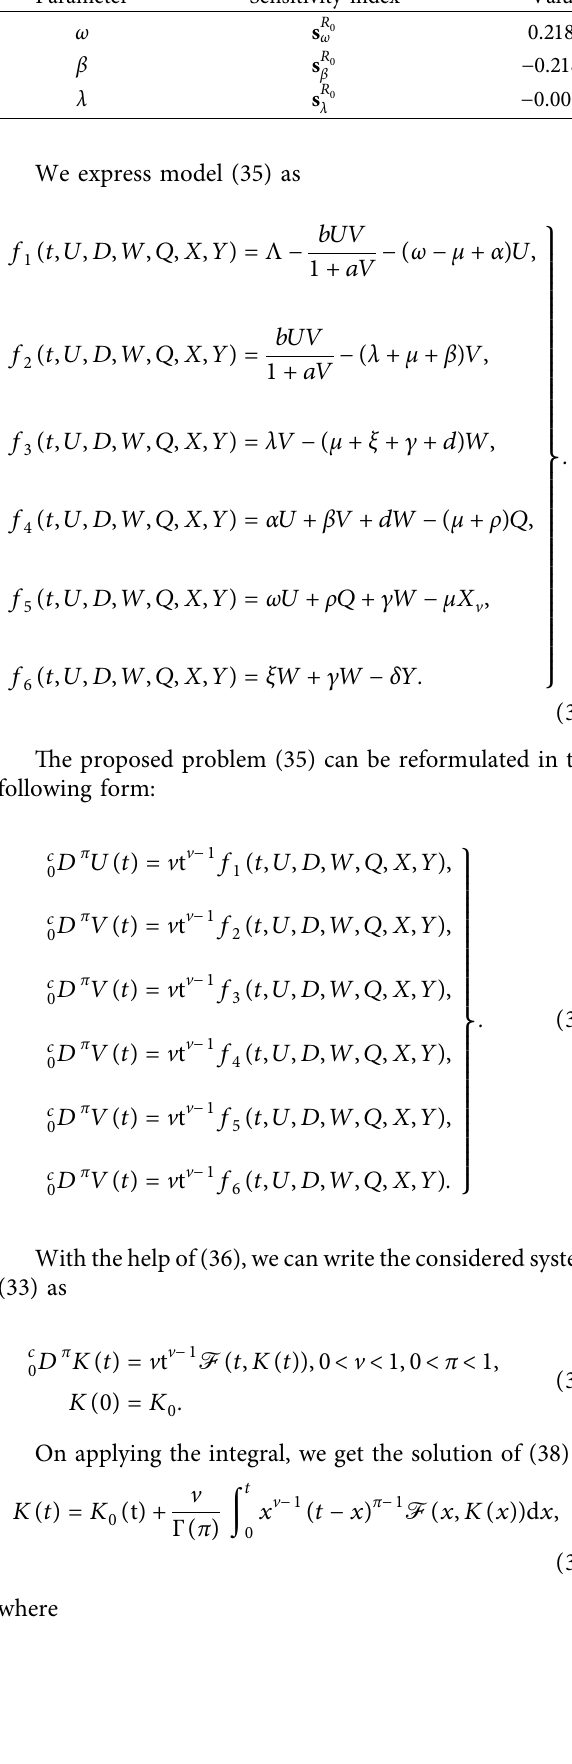
Table 3: Sensitivity of the R